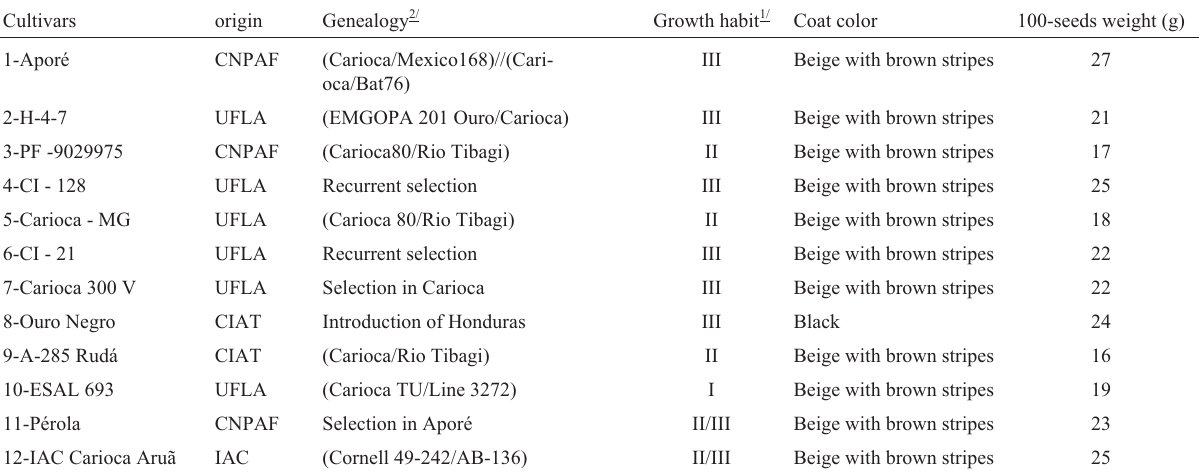
Table I - Origin, genealogy, growth habit, coat color and 100-seeds-weight of 12 common bean cultivars/lines.